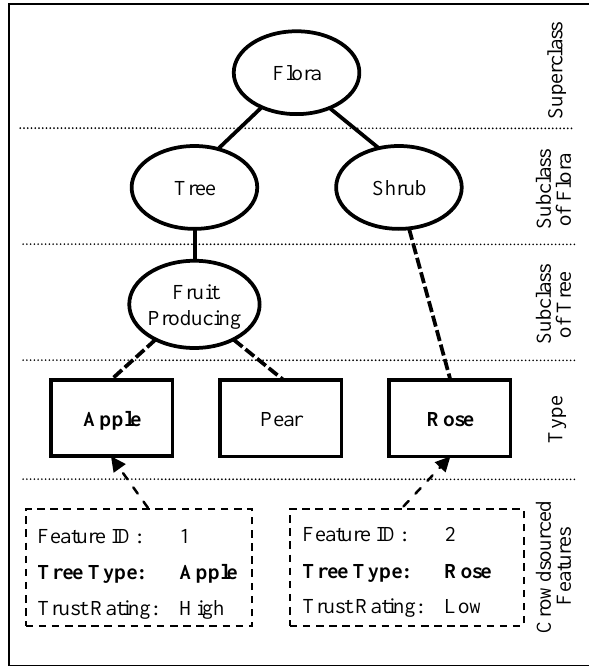
Figure 1. Assessing crowdsourced features with an ontology to determine if their Tree Type attribute is a type of fruit